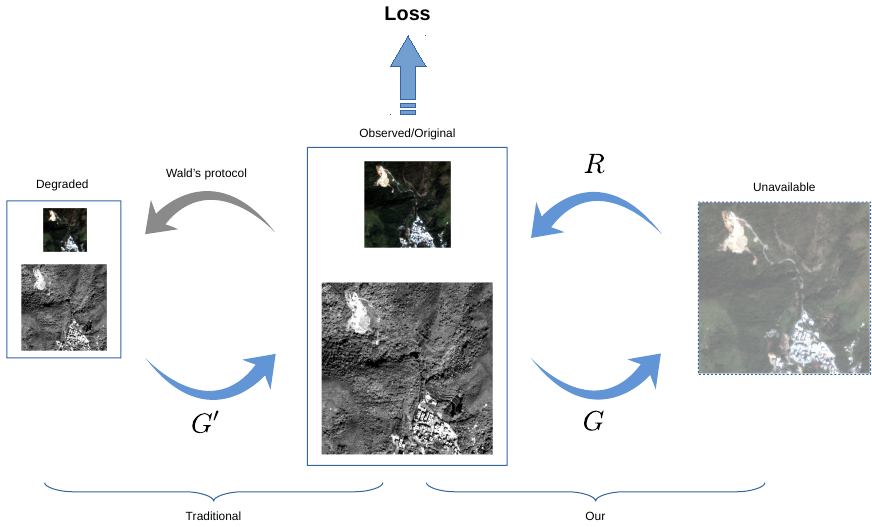
Figure 1. Different perspectives to train pan-sharpening models. Left: traditional supervised perspective; Right: proposed unsupervised